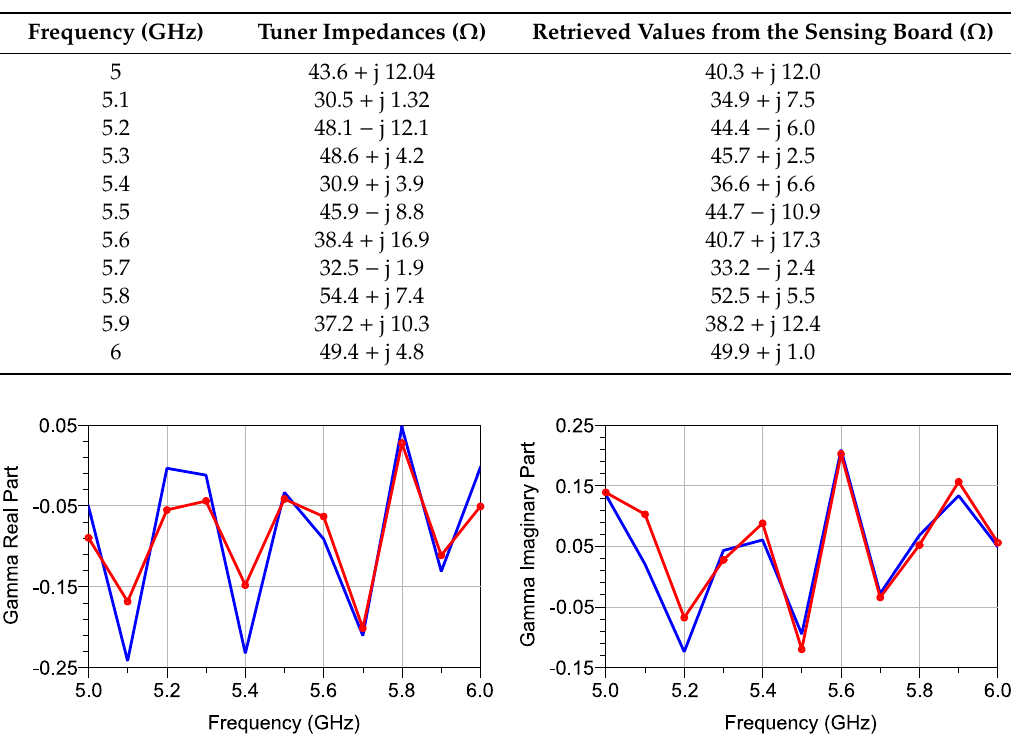
Figure 13. Measurement results are reported. Red circle line shows the reflection coefficient in terms of real and imaginary part set at the tuner. Blue solid line shows the reflection coefficient in terms of real and imaginary part retrieved from the sensing board.